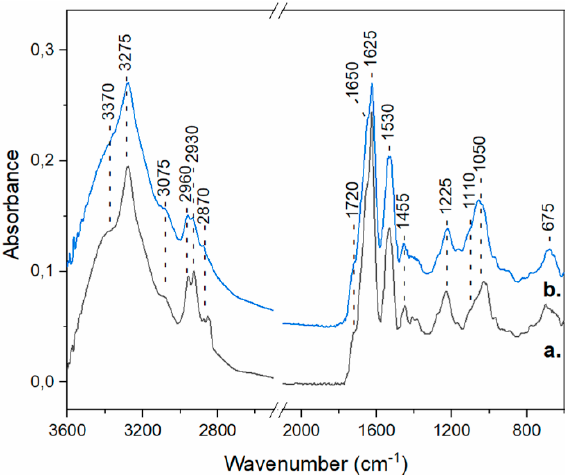
Figure 4. FT-IR analysis of the novel BS extracted and partially purified from P. citronellolis isolate 620C culture with 1% DCF as substrate: (a) without and (b) with the supplementation of FeSO 4 .